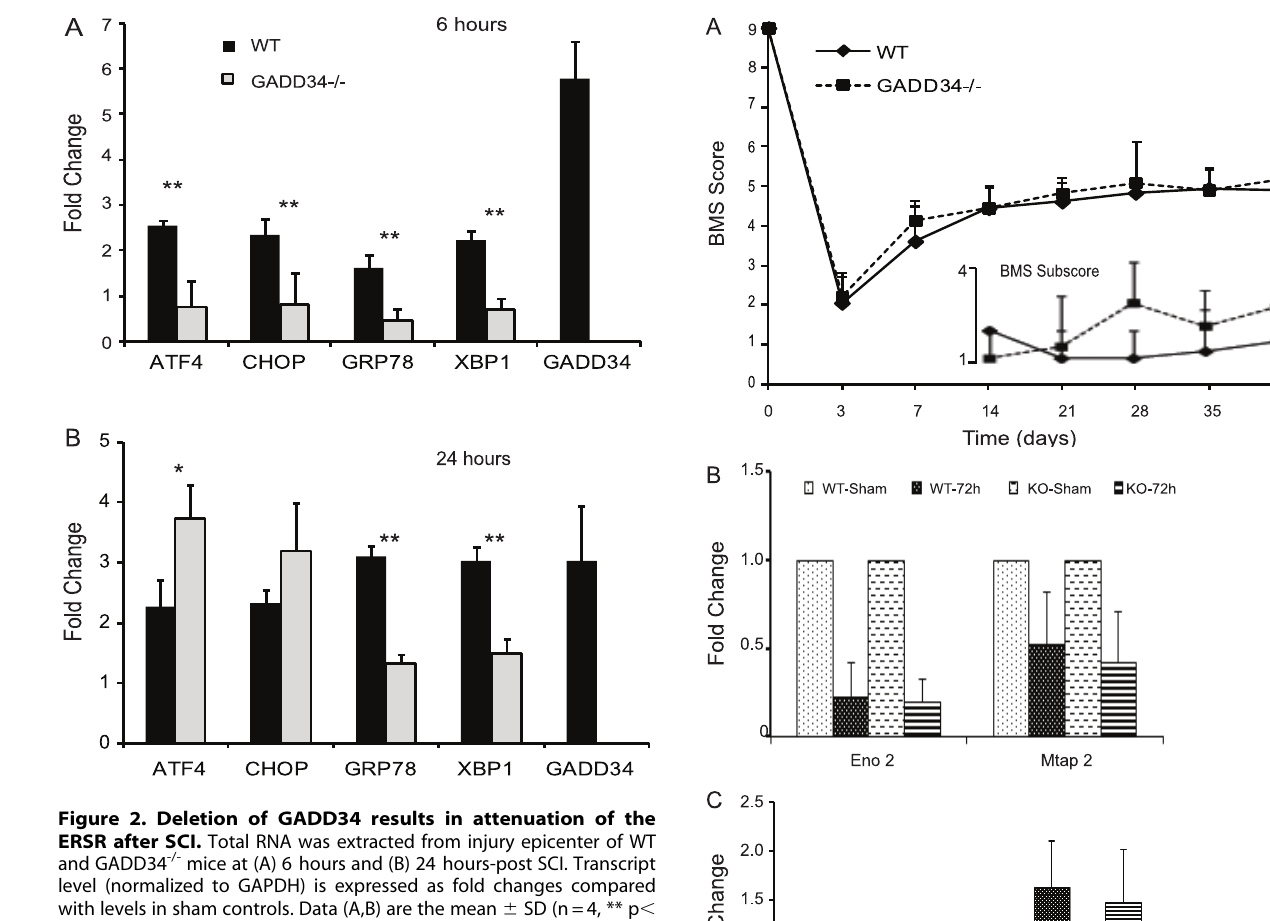
each cDNA sample were normalized to triplicate value for GAPDH (reference gene) from the same cDNA preparation.